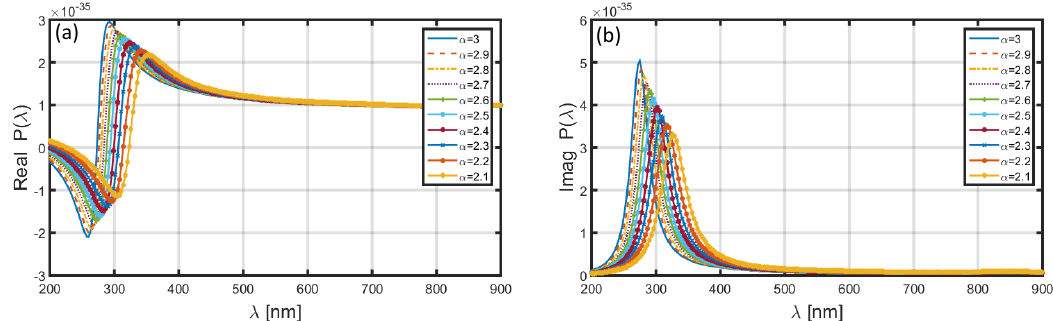
Figure 3. Wavelength-dependence of the ( a ) real and ( b ) imaginary parts of polarizability of the nanoparticle coated with Al.